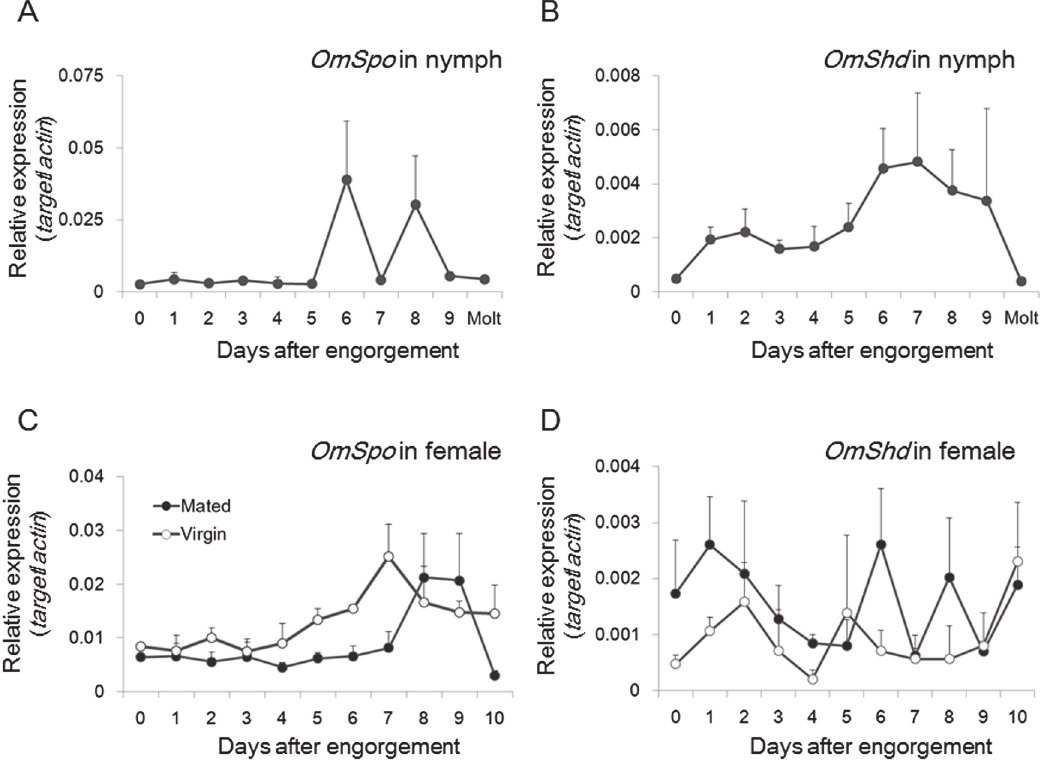
Fig 7. Developmental changes in OmSpo and OmShd expression during nymphal development or egg maturation in adult females. OmSpo (A) and OmShd (B) expression in nymphs was determined for ovaries and midgut, respectively. OmSpo (C) and OmShd (D) expression in adult females determined for ovaries and midgut, respectively. (n = 3 – 4, mean ±